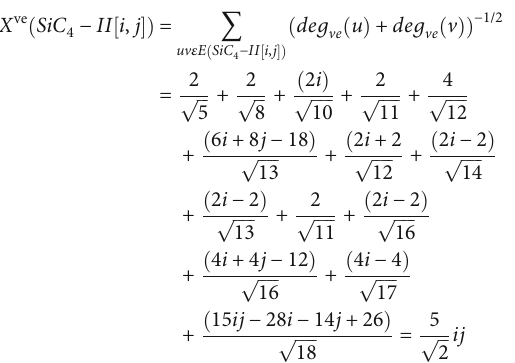
Table 7 of end vertices of the edges of SiC we can estimate the ve-deg-related sum connectivity index as